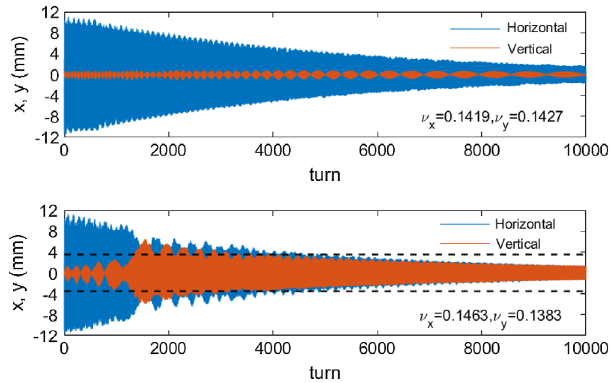
FIG. 7. Horizontal and vertical oscillations for the injected beam for the same two cases as in Fig. 6. Top: ½ ν x ; ν y (cid:2) ¼ ½ 0 . 1419 ; 0 . 1427 (cid:2) ; bottom: ½ ν ; ν (cid:2) ¼ ½ 0 . 1463 ; 0 . 1383 (cid:2) . Dashed x y lines in the bottom plot show the physical aperture at (cid:3) 3 . 5 mm.